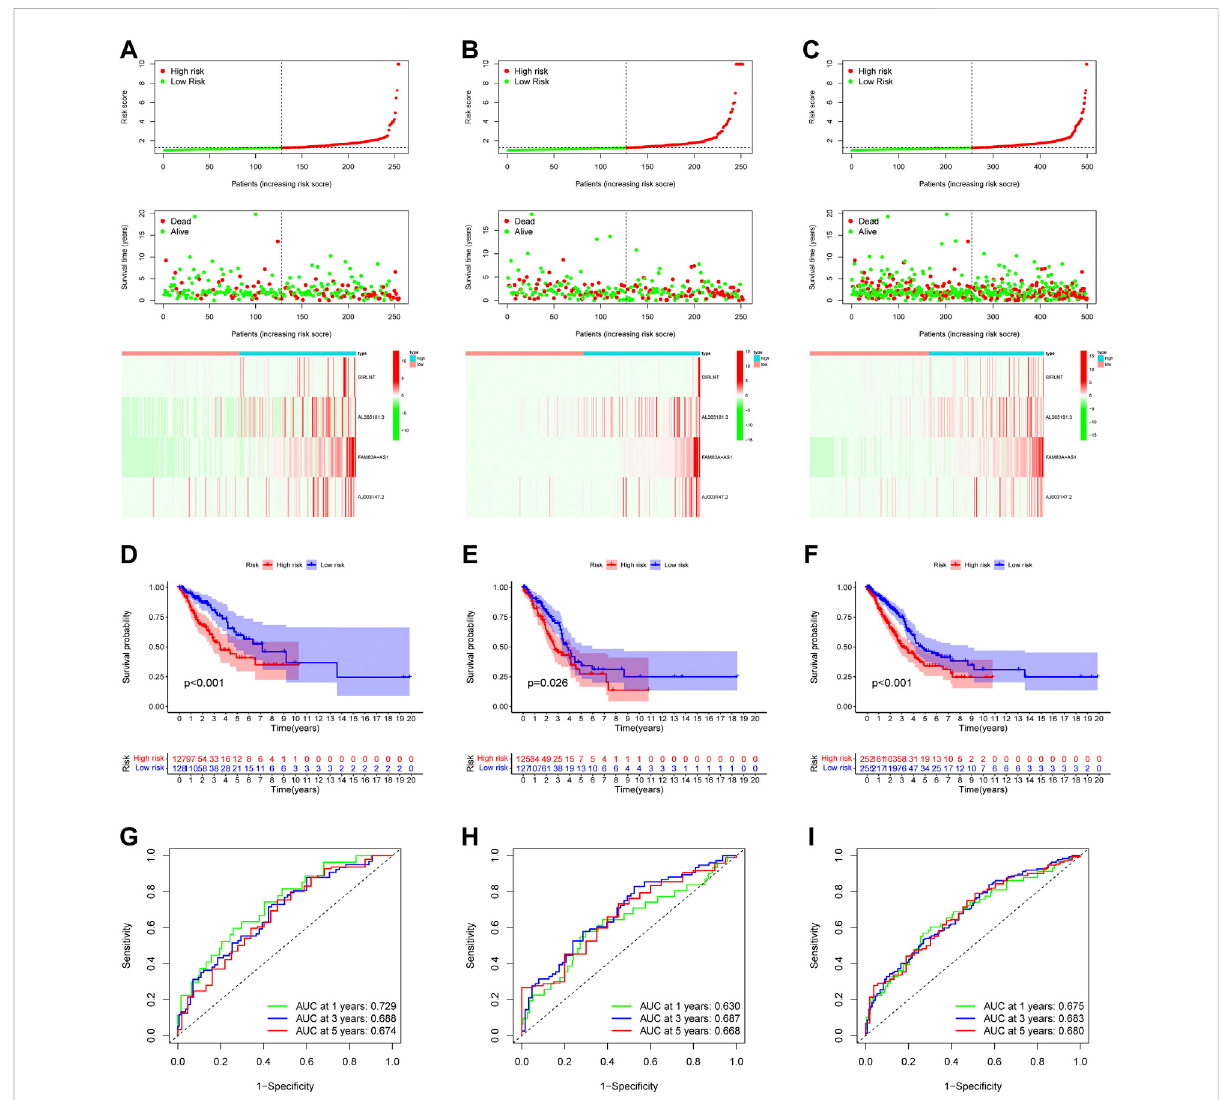
FIGURE 3 Prognostic model construction and evaluation. In the training cohort (A) , testing cohort (B) and entire cohort (C) the patient with different risk score, survival status, and NETs-associated lncRNAs expression were shown. Survival analysis of training cohort (D) , testing cohort (E) and entire cohort (F) and the prognosis of high-risk group was signi fi cantly worse. ROC curve revealed that in the training cohort (G) , testing cohort (H) and entire cohort (I) , the AUC values for 1, 3, and 5-year OS were over